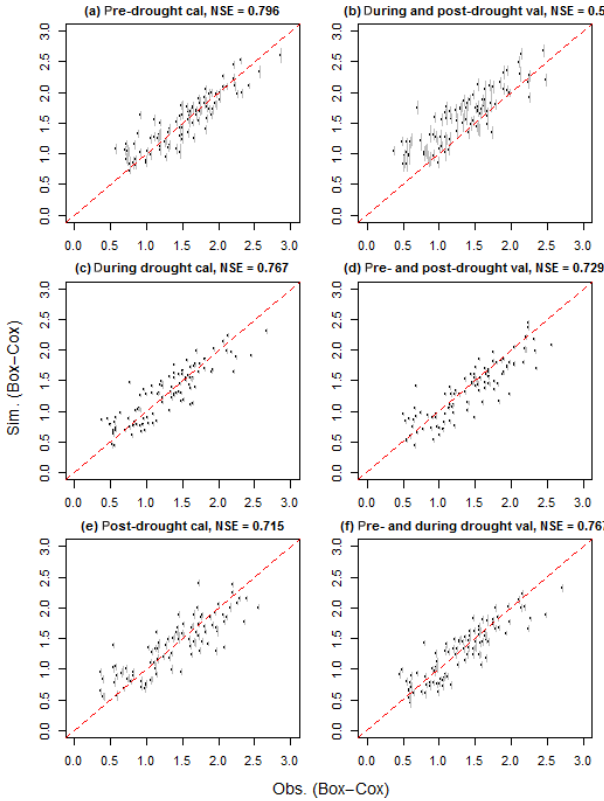
Figure 7. Comparison of the TSS model performance: the simu- lated against observed site-level mean concentrations in Box–Cox- transformed space. The left column shows the calibration perfor- mance for the model calibrated using the pre-drought (1994–1996), drought (1997–2009) and post-drought (2010–2014) periods, re- spectively; the right column shows the corresponding validation performance for each period. The 95% upper and lower bounds of the simulations are shown using vertical gray lines, and red dashed lines show the 1 : 1